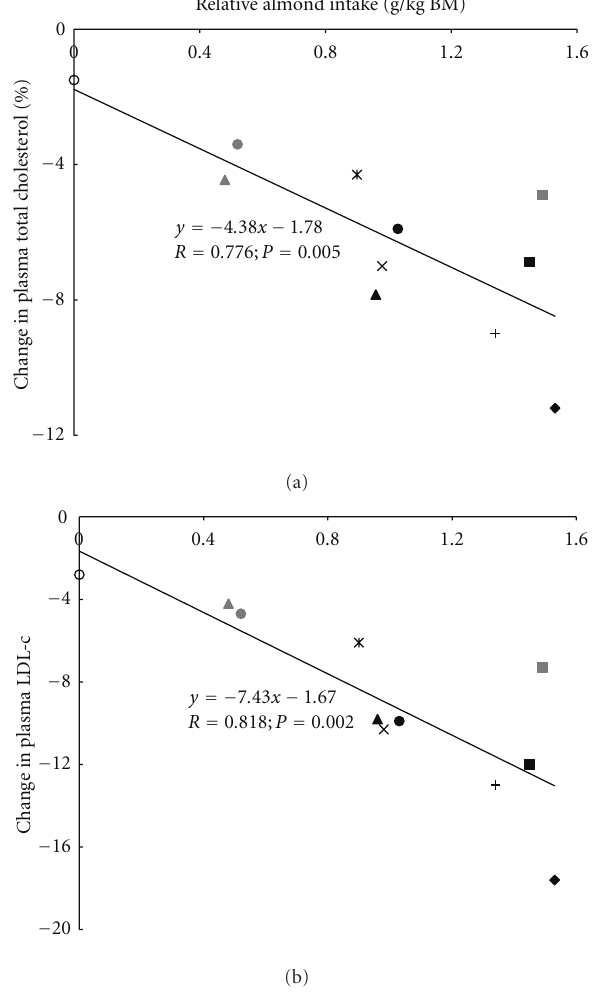
Figure 1: Correlation between mean relative almond intake (RAI) and (a) percent change in mean plasma total cholesterol (pTC) and (b) percent change in mean plasma low-density lipoprotein cholesterol (pLDL-c). Correlations were considered significant at P < 0 . 05. Open circle: Jenkins et al. [18] (control diet); plus sign: Spiller et al. [20]; “X”: Abbey et al. [12]; diamond: Spiller et al. [22]; cross-thru “X”: Hyson et al. [15]; gray triangle: Sabat´e et al. [19] (low-almond diet); black triangle: Sabat´e et al. [19] [high-almond diet]; gray square: Spiller et al. [21] (roasted-almond diet); black square: Spiller et al. [21] (raw-almond diet); gray circle: Jenkins et al. [18] [half-almond diet]; black circle: Jenkins et al. [18] (full- almond